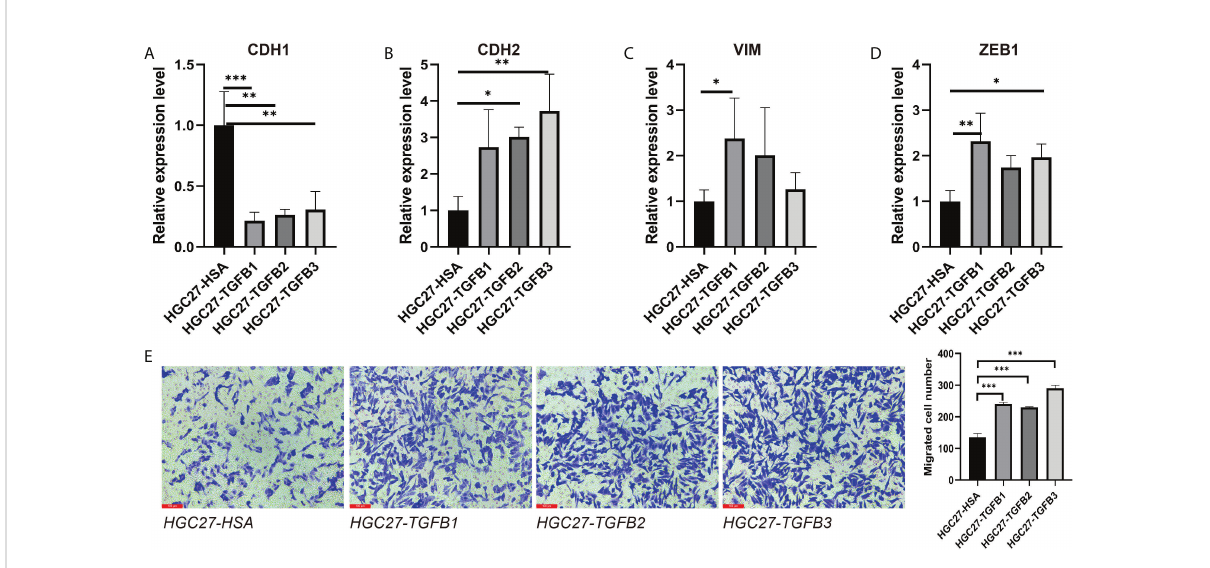
FIGURE 7 Induction of gastric cancer cells under TGF b environment. (A – D) CDH1, CDH2, VIM and ZEB1 expression in gastric cancer cells in the context of TGF b . (E) The migration ability of gastric cancer cells in TGF b experimental group and control group was detected by transwell. * P < 0.05; ** P < 0.01; *** P <